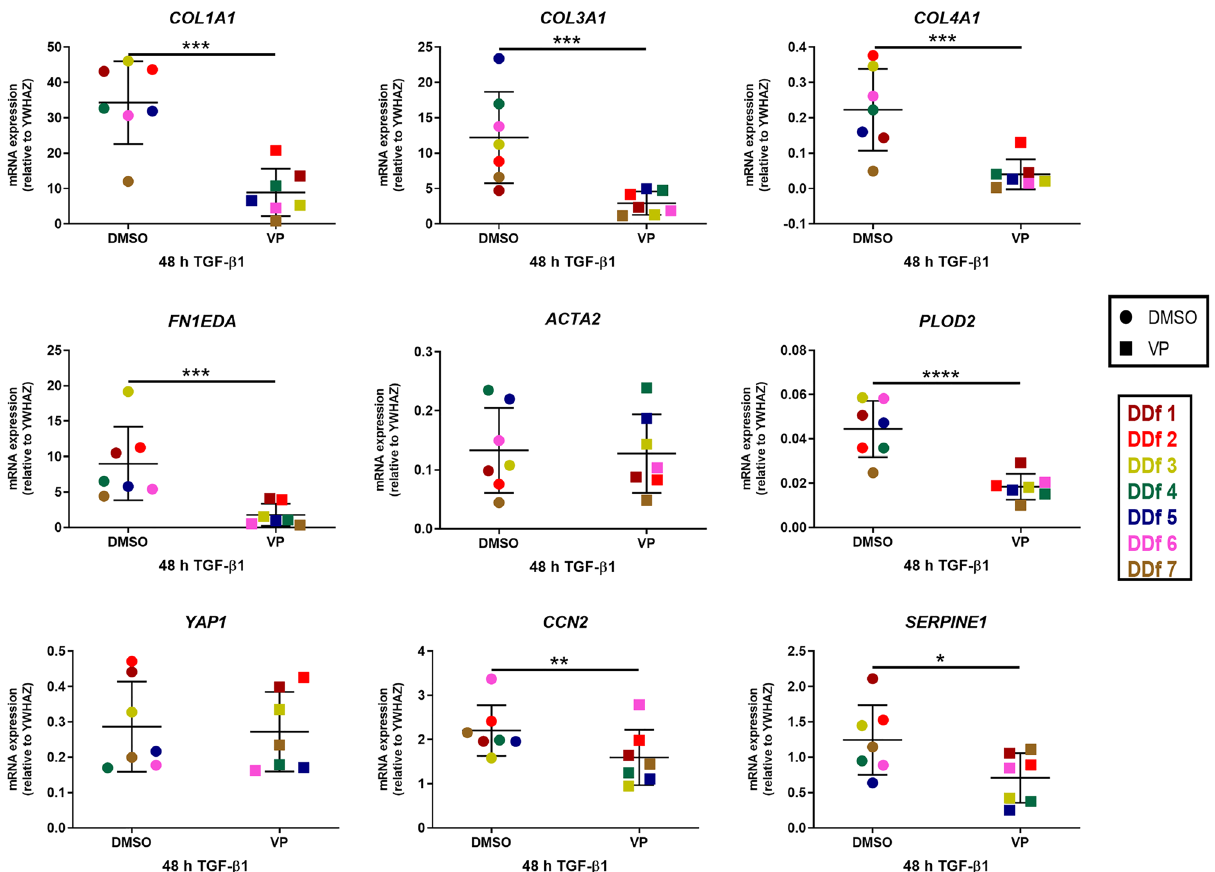
Figure 3. Effect of VP on DD nodule-derived fibroblasts exposed to 48 h of TGFβ1 (n = 7). mRNA expression of COL1A1, COL3A1, COL4A1, FN1EDA, ACTA2, PLOD2, YAP1, CCN2 and SERPINE1 relative to YWHAZ after 48 h of treatment with VP (with DMSO as control) in the absence of